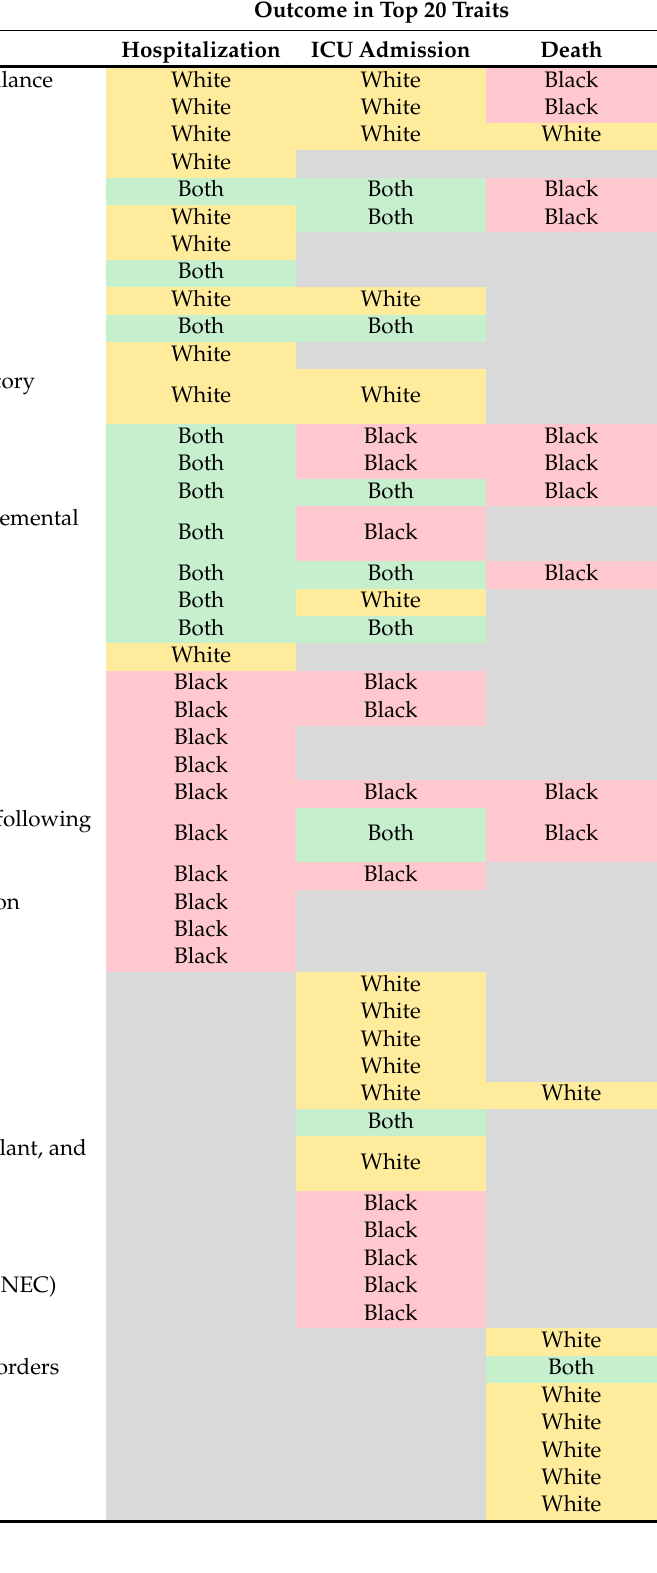
Outcome in Top 20